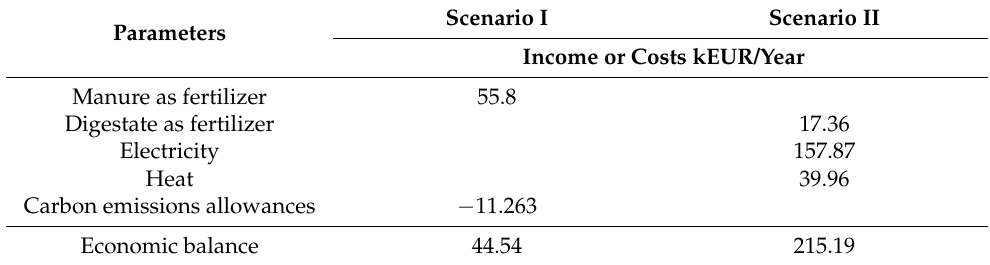
Table 8. Economic balance of the analyzed scenarios (with or without biogas plant).